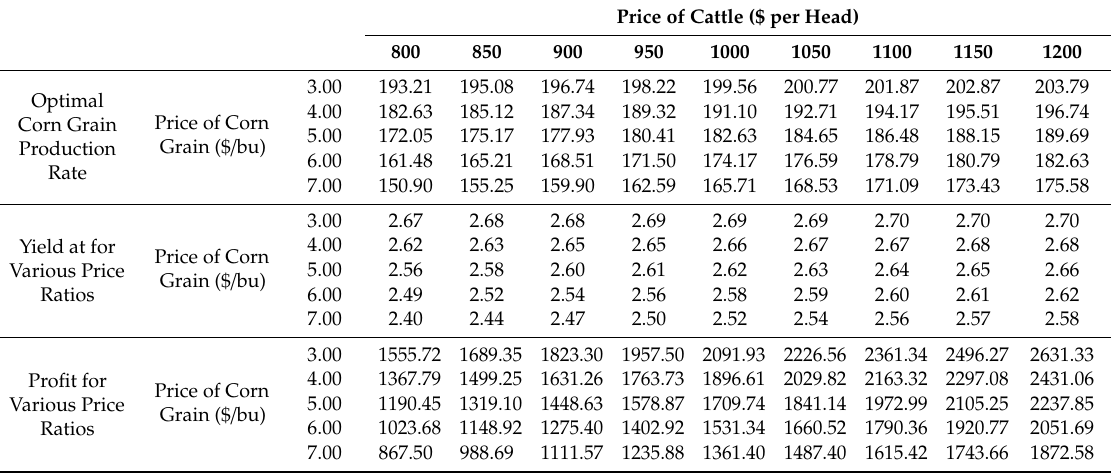
Table 5. Optimal corn grain production rate, yield and profit for various price ratios, quadratic